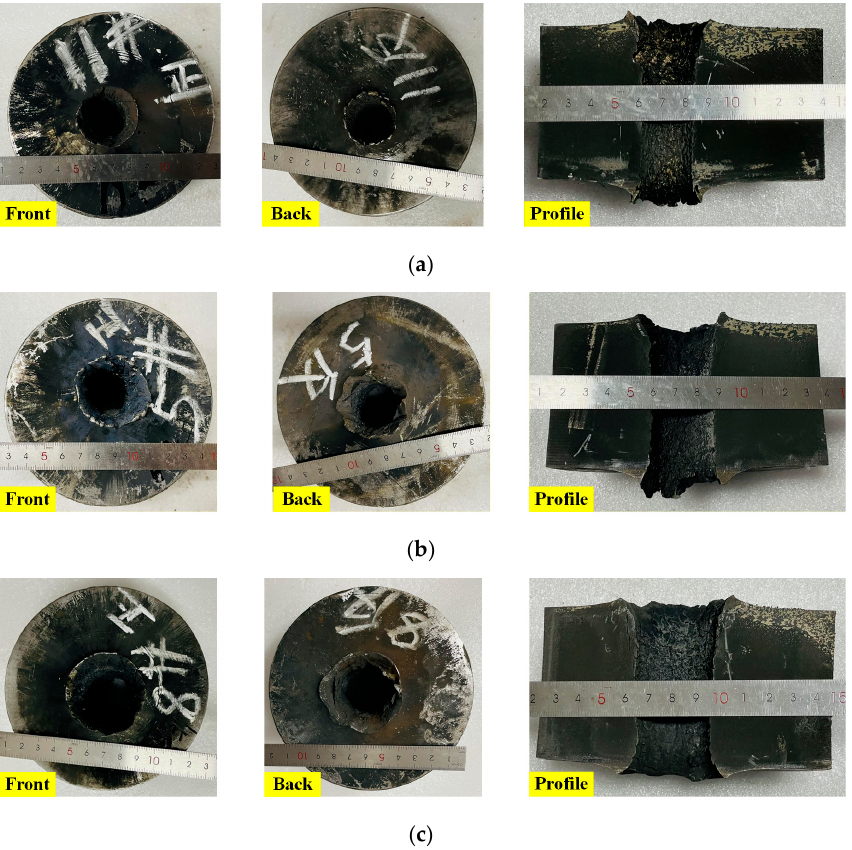
Figure 5. Perforation effects of the steel targets due to composite jets impact: ( a ) reactive material– Cu jet; ( b ) reactive material–Ti jet; ( c ) reactive material–Al jet. jet; ( b ) reactive material–Ti jet; ( c ) reactive material–Al